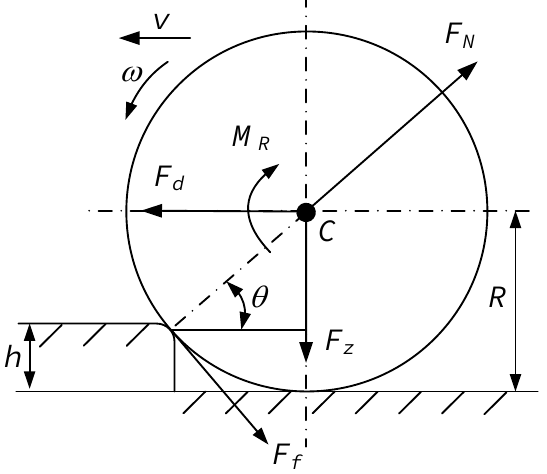
Figure 4. Force analysis on the tire.